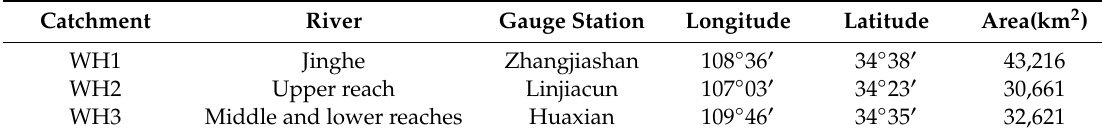
Figure 1. The Weihe River basin. Table 1. Information on the three sub-regions investigated in this study.